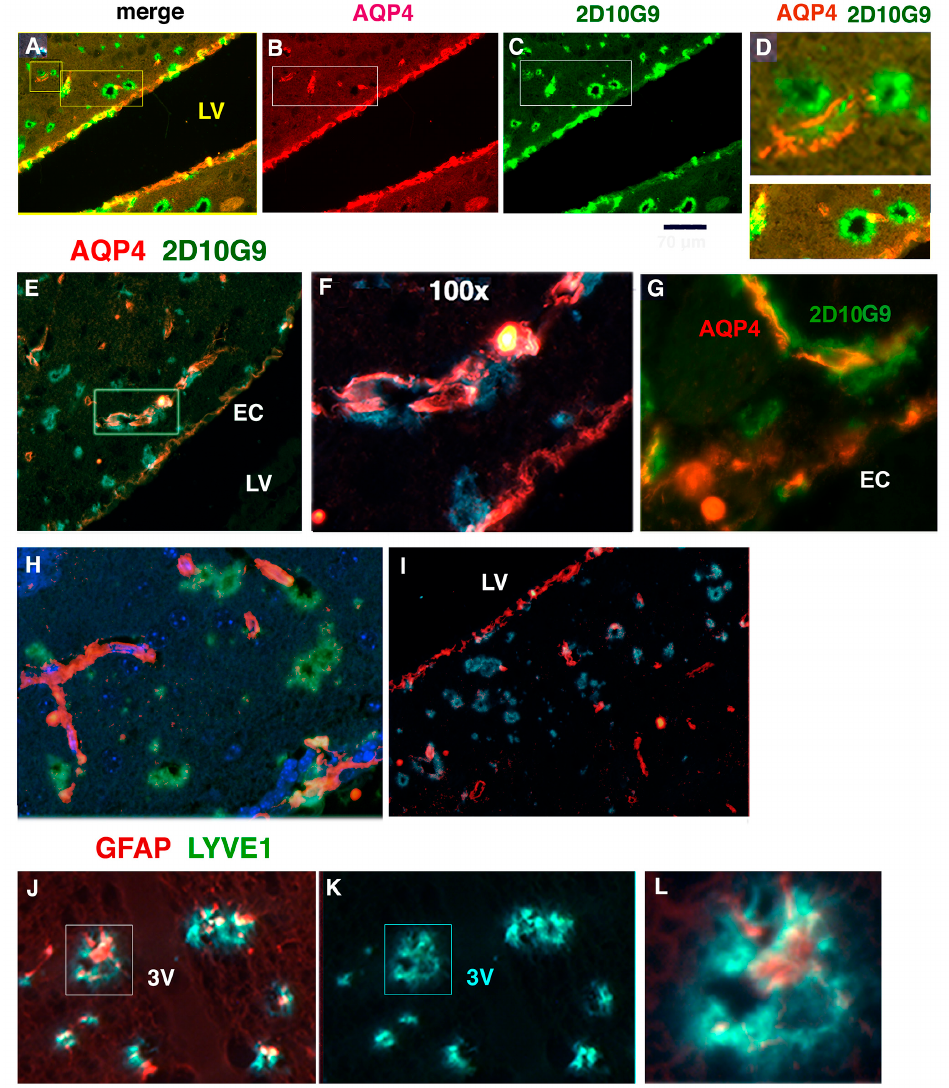
Figure 6. Colocalization of AQP4 and HOCl-modifed epitopes in vessels near the lateral ventricles suggest a role for MPO in glymphatic impairment ( A – C ). Immunostaining of hMPO-A53T brain shows 2D10G9 and AQP4 costained in a subset of ependymal cells lining the lateral ventricle (LV) ( A ). Scale bar under C, 70 um. ( B ) AQP4 staining is seen in the ependymal cells and a few vessels in the boxed area. ( C ) 2D10G9 staining is seen in adjacent vessels in the boxed area and in some ependymal cells. ( D ) The small box in Panel ( A ) is enlarged in ( D ) to show two 2D10G9 positive vessels (green) with AQP4 (red) in filaments or astrocytic sheath encircling the vessel. The lower Panel shows a region from the big box in A with 2D10G9 stained vessels (green) colocalizing with AQP4 (red). ( E – I ) Panel ( E ) shows AQP4 (red) and 2D10G9 (green) staining along a vessel near the ependymal cells (EC) of the lateral ventricle (LV). The boxed area is enlarged in panel ( F ) showing what appears to be distinct layers of AQP4 and 2D10G9 staining. Panel ( G ) shows another example of AQP4 and 2D10G9 in layered staining along a vessel. Panel ( H ) show AQP4 (red) in vessels whose ends interact with 2D10G9 (green) stained vessels. Panel ( I ) shows AQP4 again in vessels that contact 2D10G9 vessels without colocalizing. Panel ( J ) show colocalization of GFAP (red) astrocyte marker, and LYVE1 (green) glymphatic marker in the vessels along the 3rd ventricle (3V) (not DAPI stained). Panel ( K ) shows LYVE1 staining only, which allows visualization of lumens in some vessels. Panel ( L ) shows the boxed area in Panel ( J ) enlarged to reveal lumens in LYVE1+ vessels around GFAP astrocyte marker (red).20 × and 40 × objectives was used in ( A – E ), ( H – K ), and 100 × objective in ( F , G , L